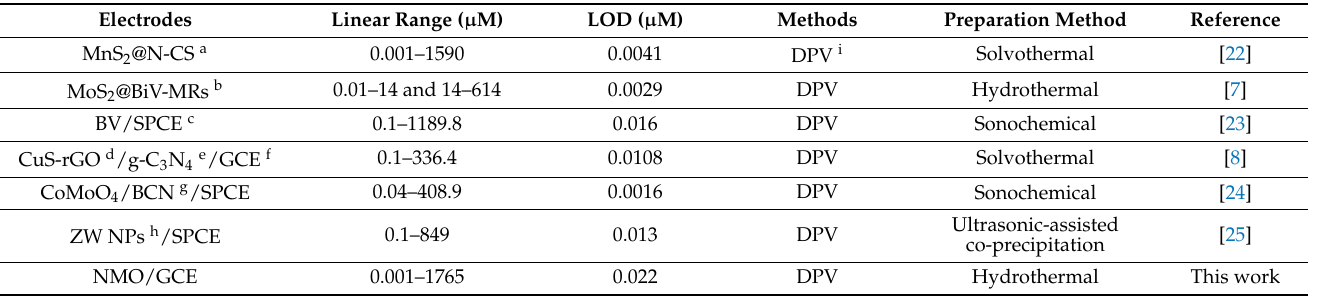
Table 1. The obtained electrochemical parameters of NMO/GCE for the electrochemical detection of FZE were compared with other